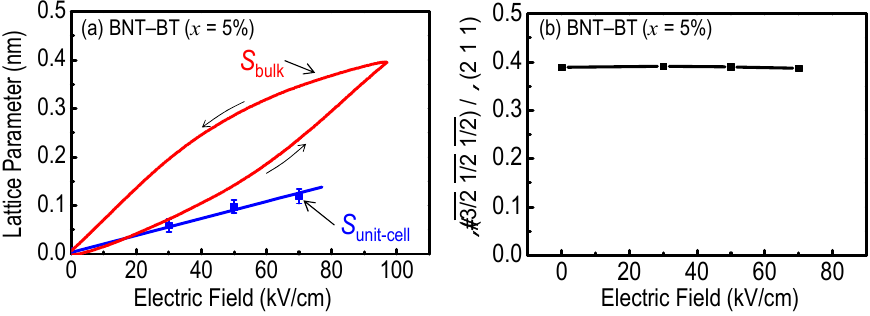
) observed for the BNT–5%BT crystals along Figure 5. ( a ) Unipolar strain curve ( S bulk at 25 °C. The unit-cell strain ( S ) calculated from the lattice parameter c <001> pc unit-cell determined in the SR-XRD analysis is also plotted. Figure ( b ) with respect to E in-situ represents the intensity ( I ) ratio of superlattice 2/12/12/3 reflection to fundamental 112 one as a function of E applied along <001> for the BNT–5%BT in-situ pc